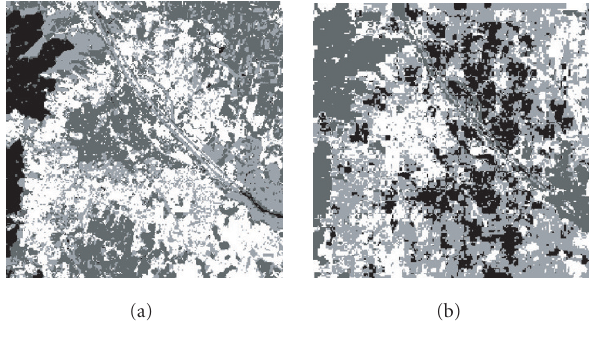
Figure 6: Segmentation results: (a) γ = 1 . 8 and (b) γ = 2 . 8.